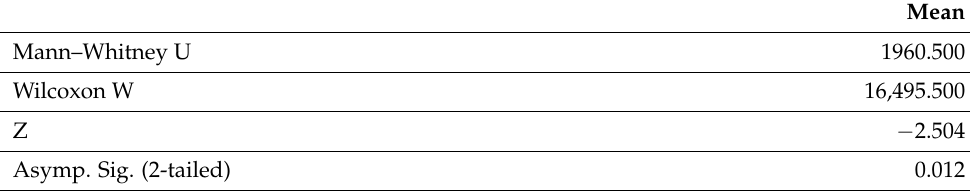
Table 15. Test Statistics a .